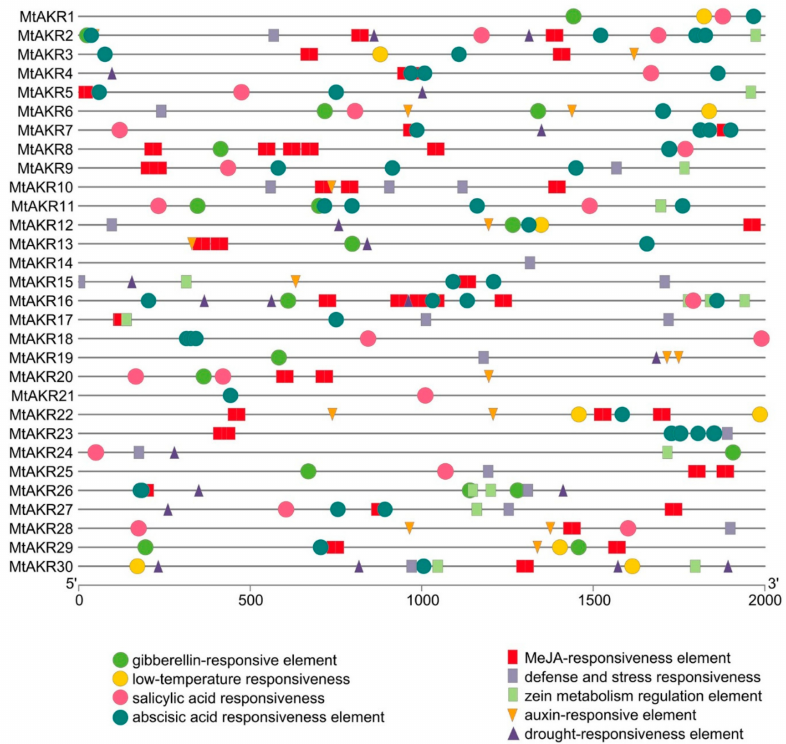
Figure 4. Distribution of major stress- and hormone-related cis-acting regulatory elements in the promoters of putative M. truncatula AKR genes. TC-rich repeats (defense and stress), MBS (drought), and LTR (low-temperature responsive) elements, TGA- element / AuxRR-core (auxin), O2-site (zein metabolism), TCA-element (salicylic acid), ABRE (abscisic acid), GARE-motif / P-box / TATC-box (gibberellin), and CGTCA-motif / TGACG-motif (MeJA responsive element) are represented by di ff erent symbols, as indicated in figure key at the